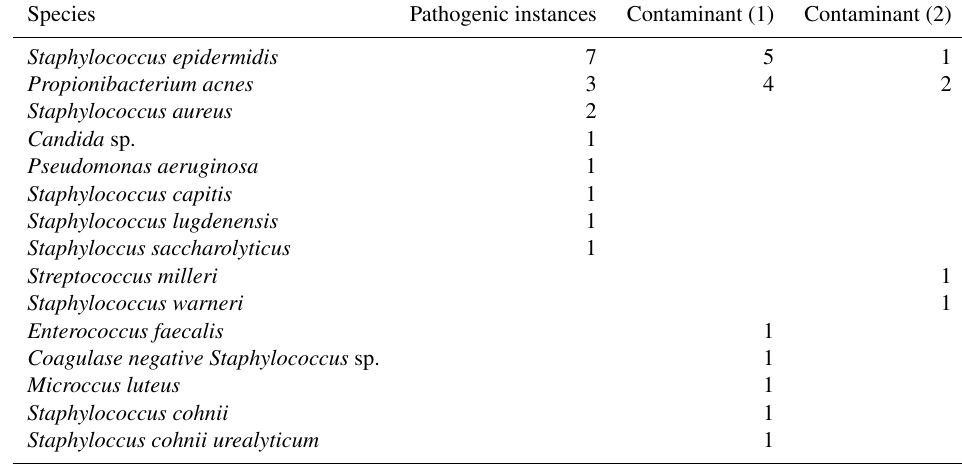
Table 3. Pathogens and contaminants. Pathogenic indicates that three or more tissue samples grew concordant species. Contaminants are cases where fewer than three tissue samples grew concordant species; this has been subdivided to show when a single or two tissue samples were culture positive.